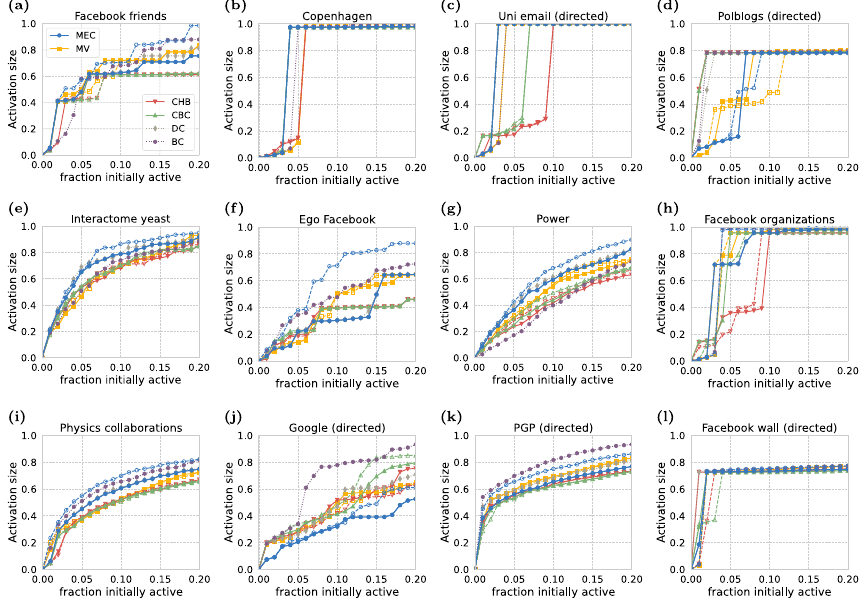
Fig. 9 Activation size for map equation centrality (MEC), modularity vitality (MV), community hub-bridge (CHB), community-based centrality (CBC), degree centrality (DC), and betweenness centrality (BC) in twelve empirical networks under the linear threshold model with threshold t ′ = 0.4 . Community structures are identified with Infomap; solid lines use the unrecorded link teleportation flow model, dashed lines use recorded node teleportation